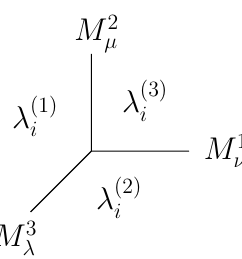
labeled by (cid:12)nite representations of the gauge groups are supported (cid:22) ; (cid:21) (2) ; (cid:21) (3) in N 1 ; N 2 and N 3 complex tori with modular parameters i i i